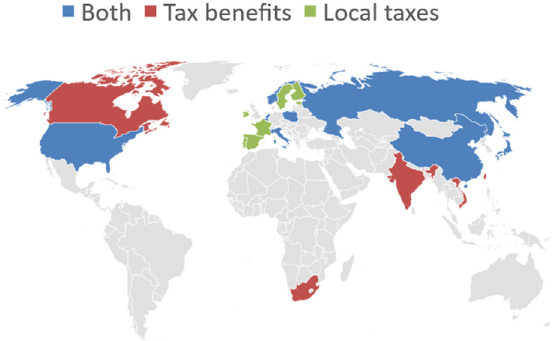
Figure 1. Map with overview of tax benefits and local taxes per country.